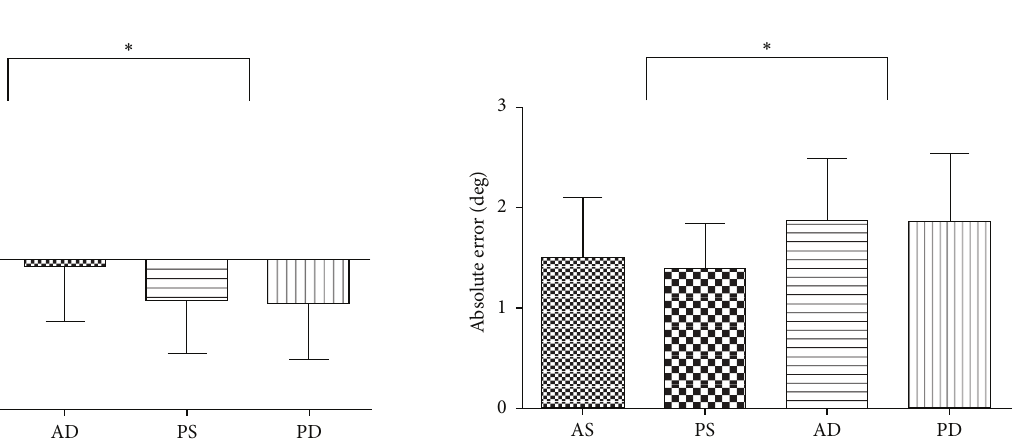
Figure 4: Mean ± SD absolute errors for each condition in experiment 1 b AS: active/single task, PS: passive/single task, AD: active/dual task, PD: passive/dual task. Table 4: Two-way ANOVA results of the joint position-matching error parameters in experiment 1b. P values derived from ANOVA for the main effects of attention and movement. Interaction between attention and